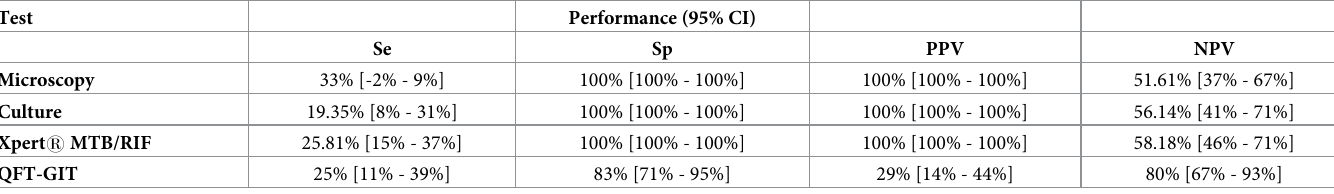
Table 5. Summary of the different analytical performances of the four (4) diagnostic techniques of